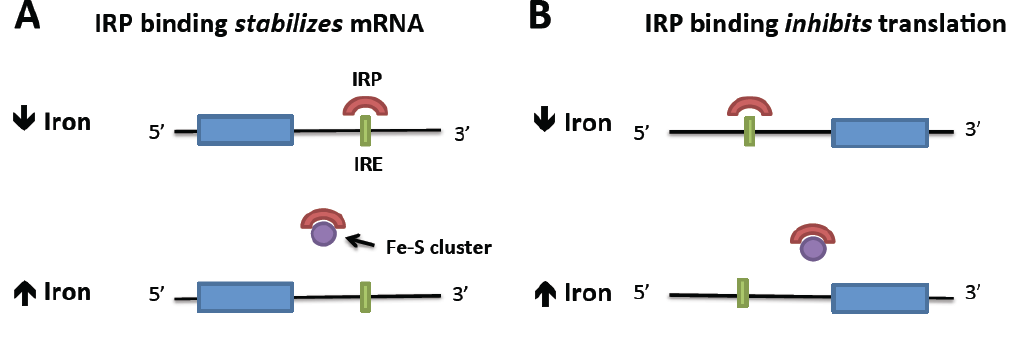
Figure 3 . Regulation of translation by intracellular iron through IRP binding to mRNA IREs. ( A ) mRNA is stabilized by the binding of the IRP to the 3′ IRE in the absence of iron. When iron is abundant, iron-bound IRP is displaced, allowing mRNA